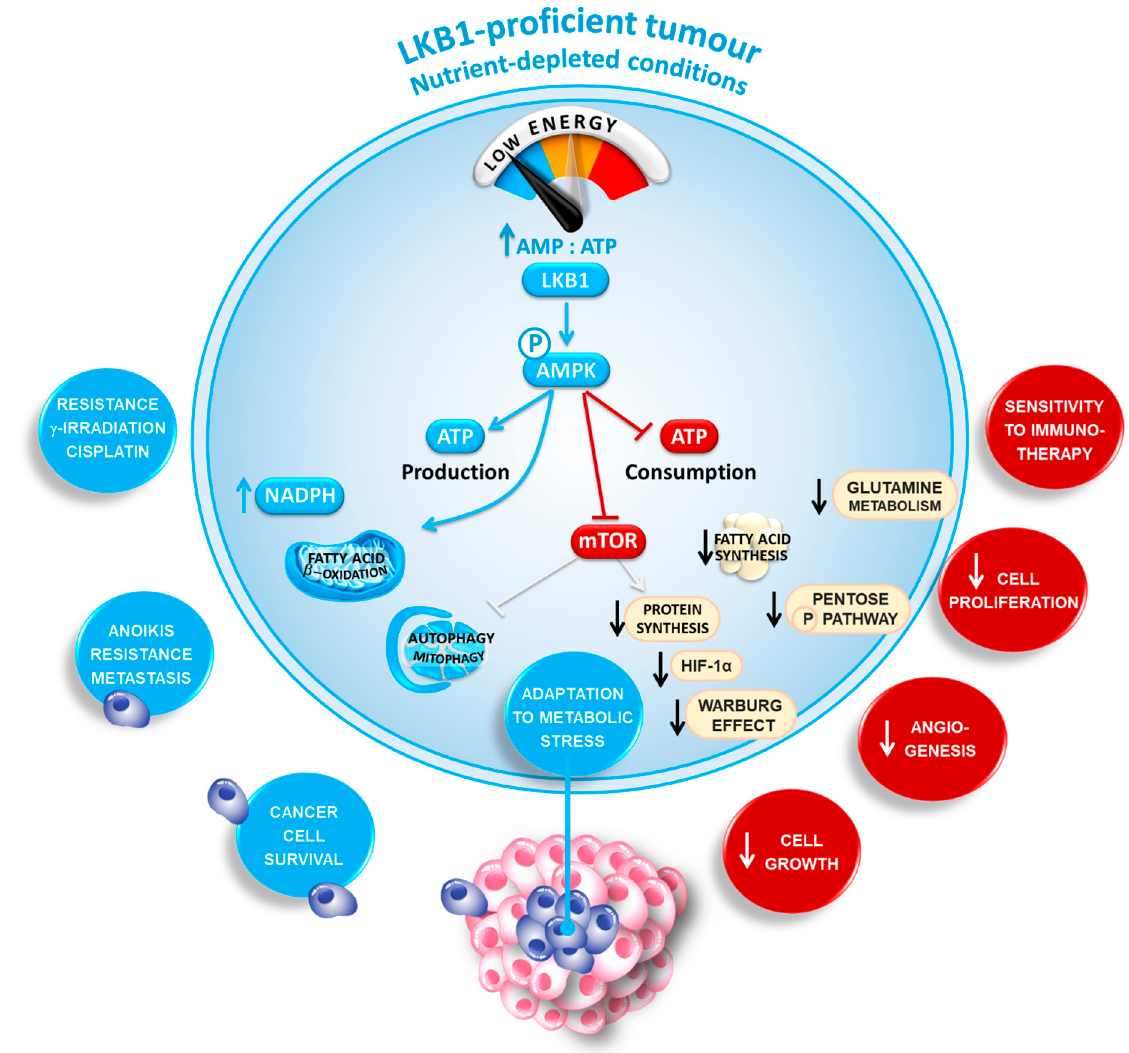
Figure 1. The double-edged sword of liver kinase B1 (LKB1) in cancer cell metabolism. LKB1 is a master metabolic sensor that acts as an energy gauge to sustain cancer cell survival. Upon nutrient deprivation within the center of large tumors, LKB1 reprograms cell metabolism by slowing down all ATP-consuming processes while simultaneously stimulating ATP-generating processes. By organizing this overall stress response, LKB1 may adapt cancer cell growth under conditions of energy shortage.